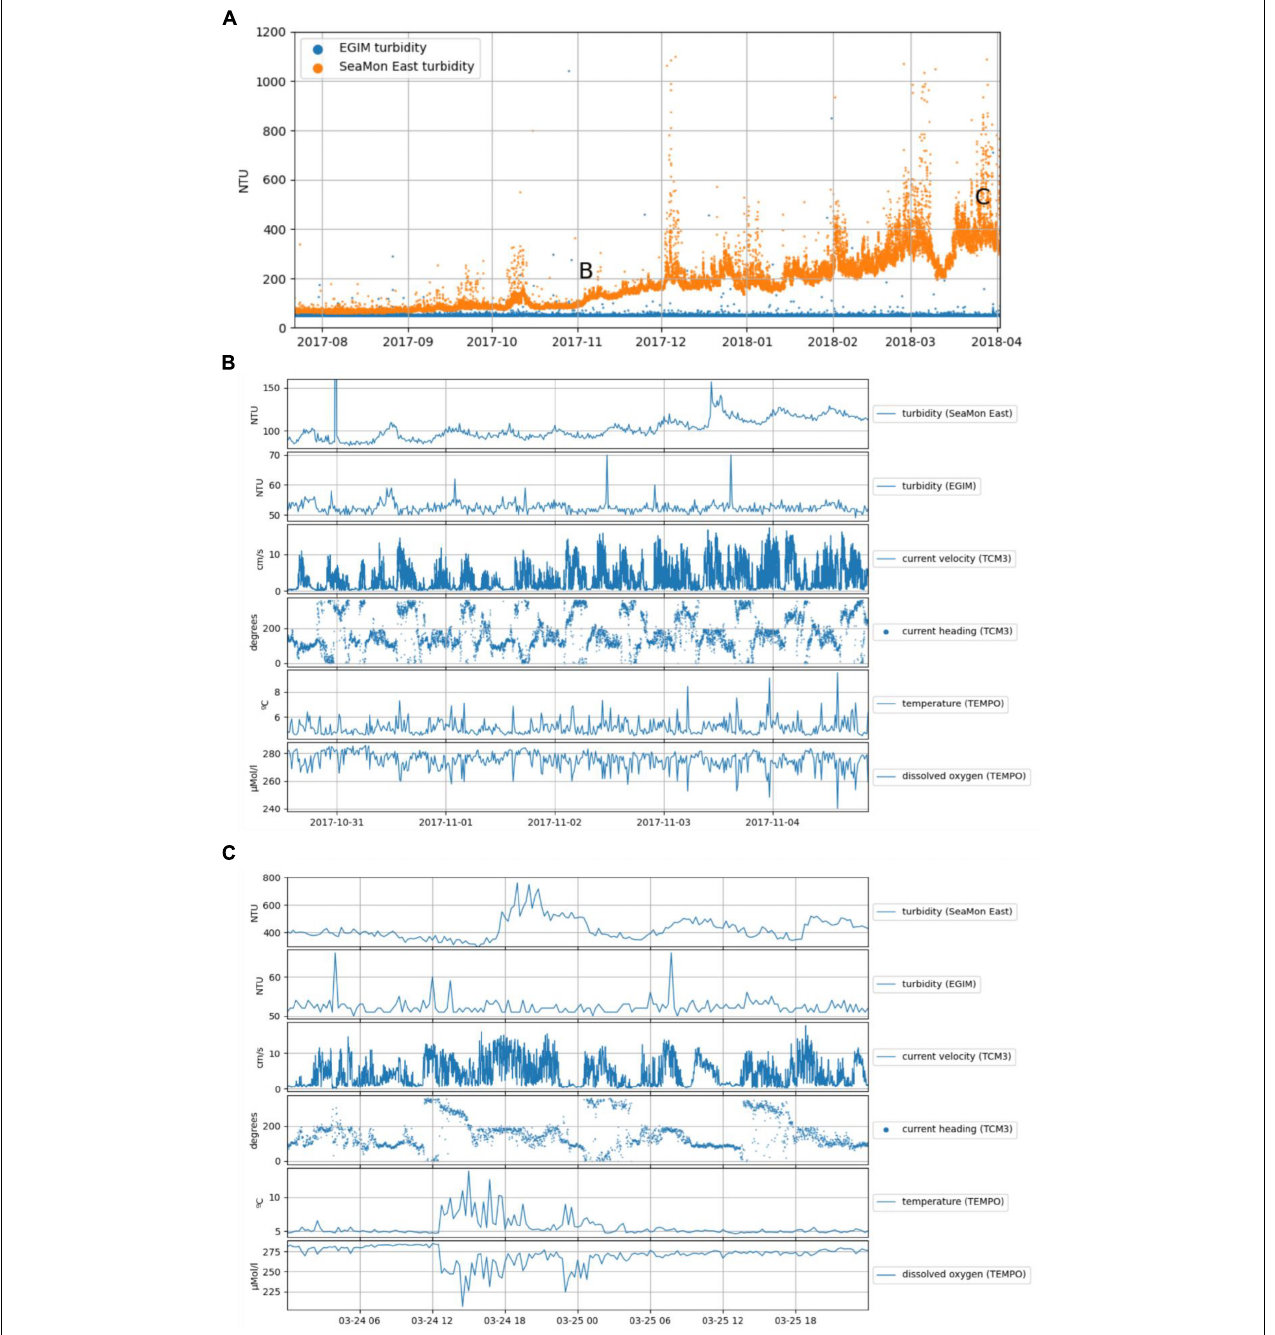
FIGURE 8 | (A) Evolution of turbidity measured by the nephelometers on the EGIM (blue) and Seamon East (orange) from 20 July 2017 to 4 April 2018. Details from the periods designated in panel (A) are shown in (B,C) . In (B) turbidity, currents, temperature and dissolved oxygen concentration from 30 October 2017 12:00 to 4 November 2018 18:00. In (C) turbidity, currents, temperature and dissolved oxygen concentration from 24 to 26 March 2018. Turbidity was measured by nephelometers deployed on the EGIM and the Seamon East. Current velocity and heading were recorded by the autonomous current meter. Temperature and dissolved oxygen concentration are from TEMPO (see Figure 7A for